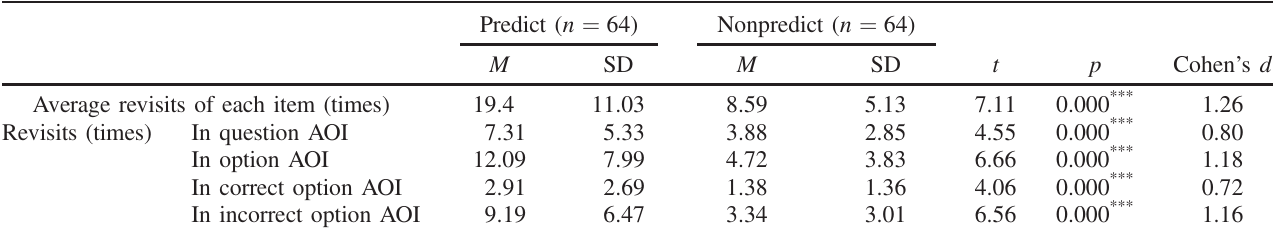
TABLE III. Results of independent sample t test on average revisits of each item between prediction group and nonprediction